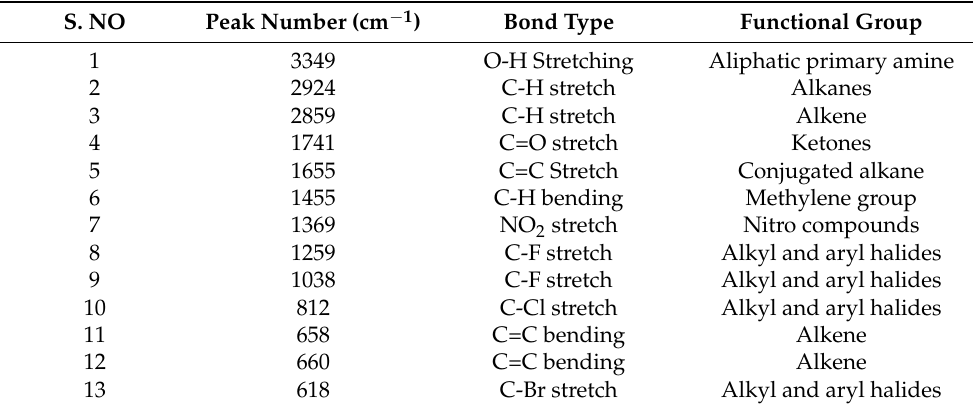
Table 4. FT-IR spectral data of the ethanolic extract of Inula racemosa . S.